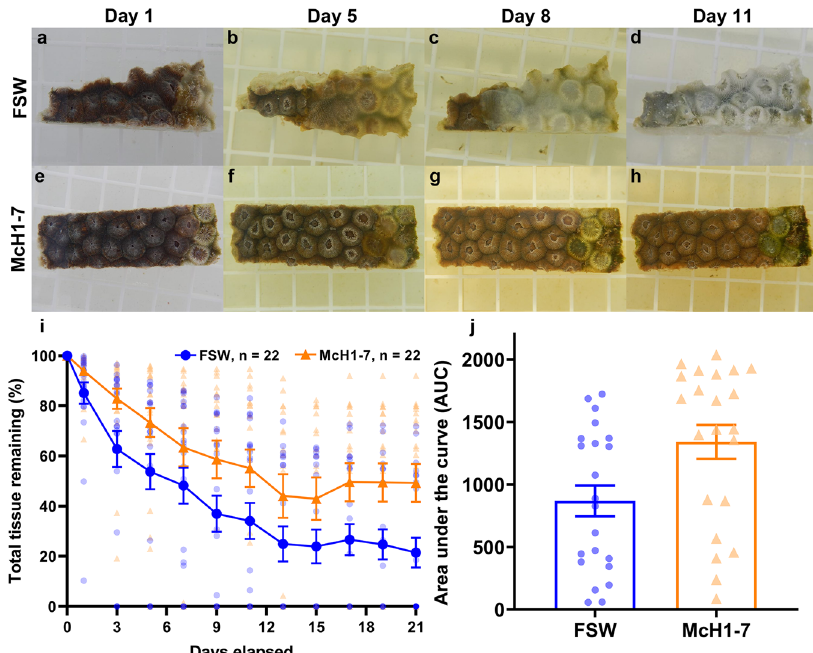
Fig. 3 Direct treatment of SCTLD with McH1-7. a – h Representative photos of diseased M. cavernosa treated with fi ltered seawater (FSW) ( a – d ) or McH1-7 ( e – h ). Photos represent days 1, 5, 8, and 11 of the experiment. In this example, the FSW treatment represents 100% tissue loss after 11 days ( d ), while the McH1-7 treatment represents 5% tissue loss after 11 days (panel h ). i Average percentage of total tissue remaining on M. cavernosa colonies treated with FSW (blue circles) or McH1-7 (orange triangles) over time (mixed-effects model ANOVA; treatment P = 0.020, time P < 0.0001, interaction P = 0.083; n = 22). The error bars represent the standard error of the mean. j Area under the curve (AUC) calculations for the diseased M. cavernosa treated with FSW or McH1-7 (paired t test, P = 0.002, n = 22 each treatment).